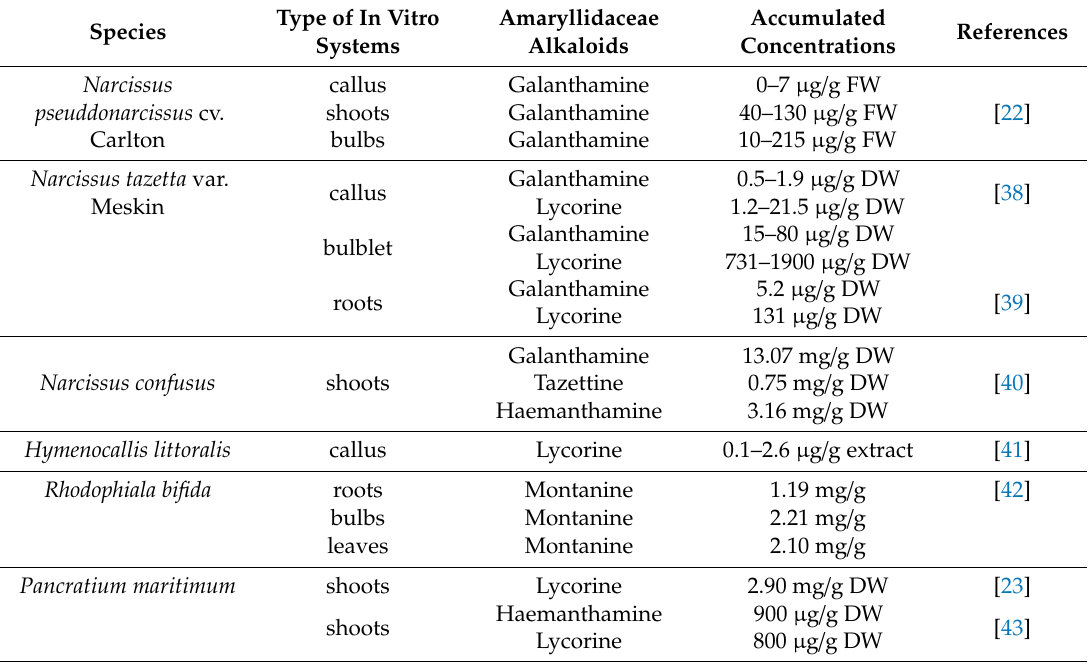
Table 1. Recent reports on plant in vitro systems synthesizing Amaryllidaceae